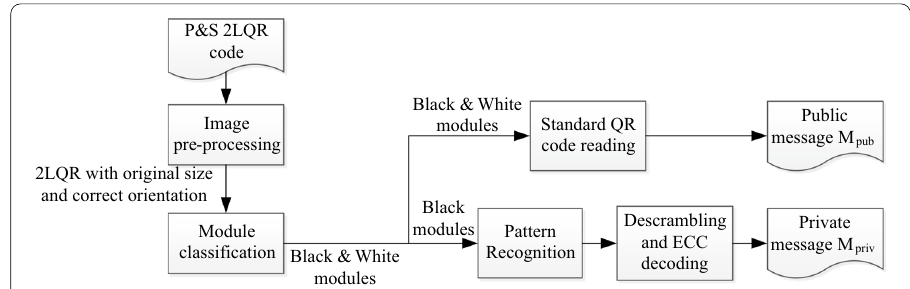
Fig. 6 The decoding process of 2LQR